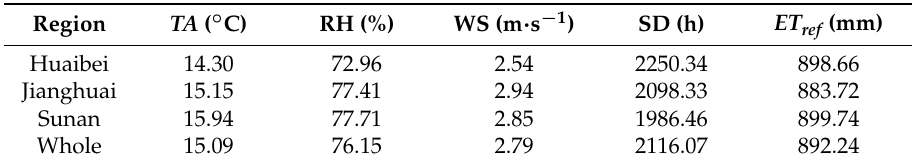
Table 1. Basic climatic characteristics of three sub-regions and the whole of Jiangsu province during